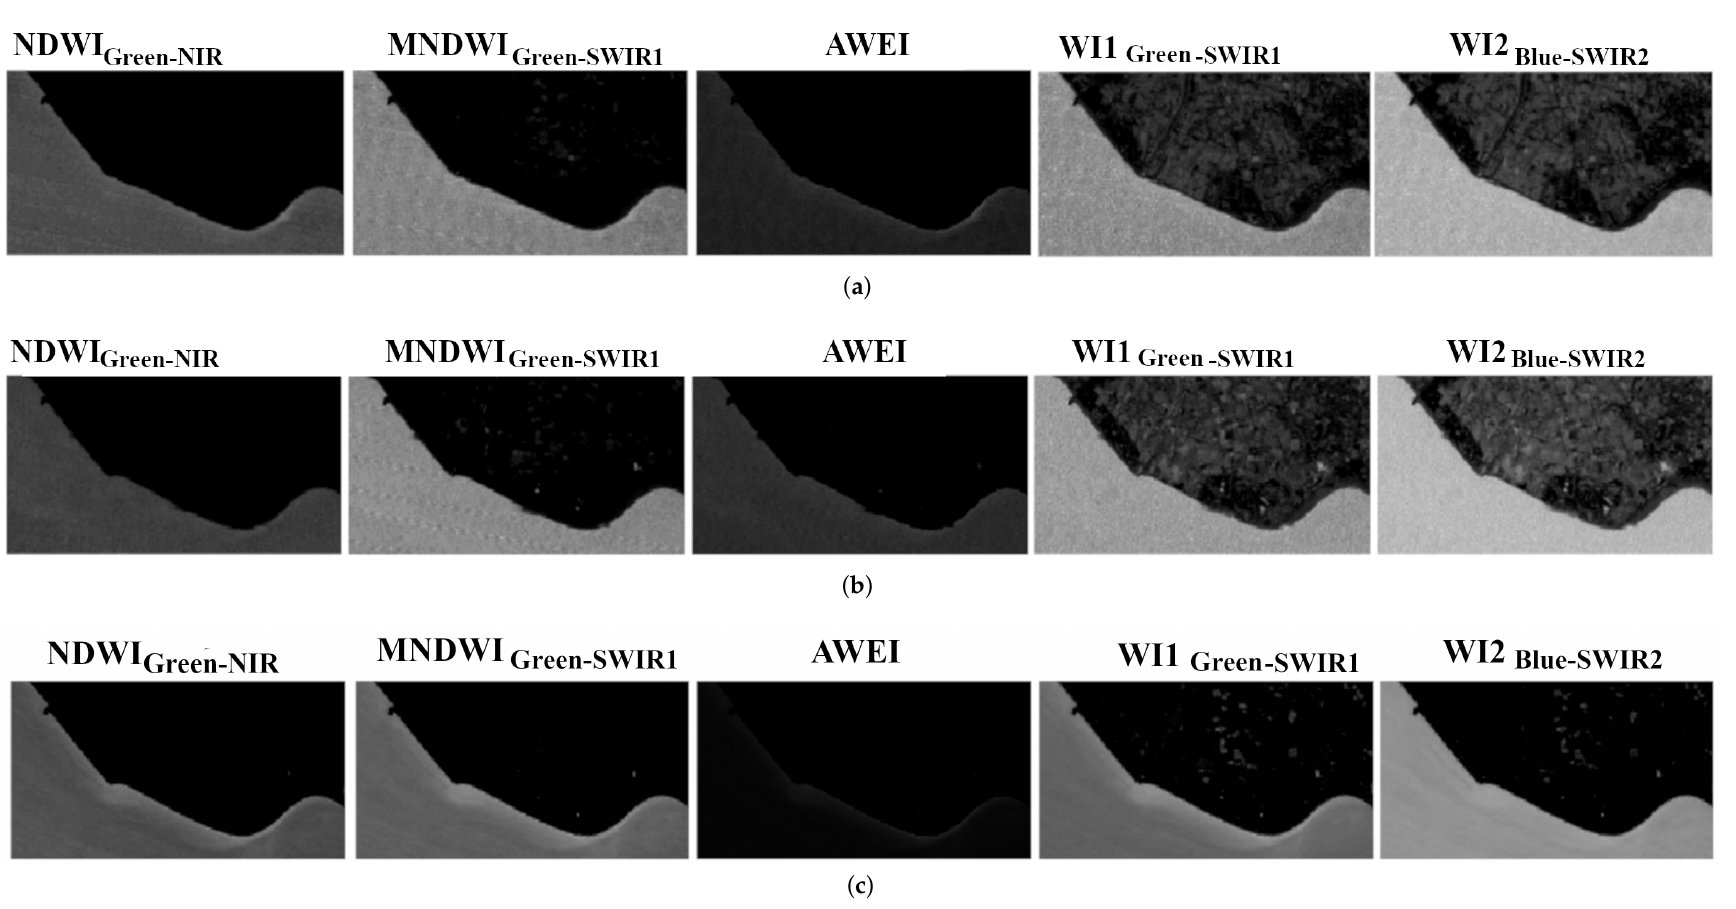
Figure 7. Water Indexes calculated for comparison in each of the sensors selected: TM, ETM+, and OLI in the Guadalfeo River Delta. ( a ) The water indexes calculated on a TM image recorded on 17 September 2003. ( b ) The water indexes calculated on an ETM+ image recorded on 20 September 2013. ( c ) The water indexes calculated on an OLI image recorded on 12 September